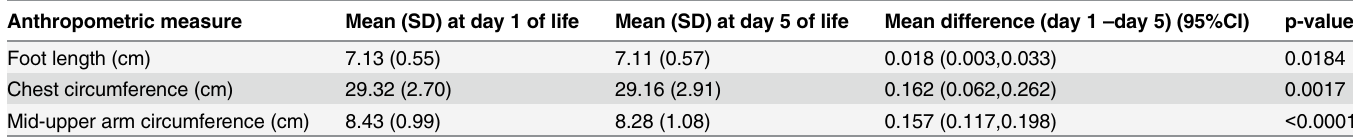
Table 3. Comparison of anthropometric measures at days 1 and 5 of life, in a subset of newborns remeasured on day 5 (N = 200). Anthropometric